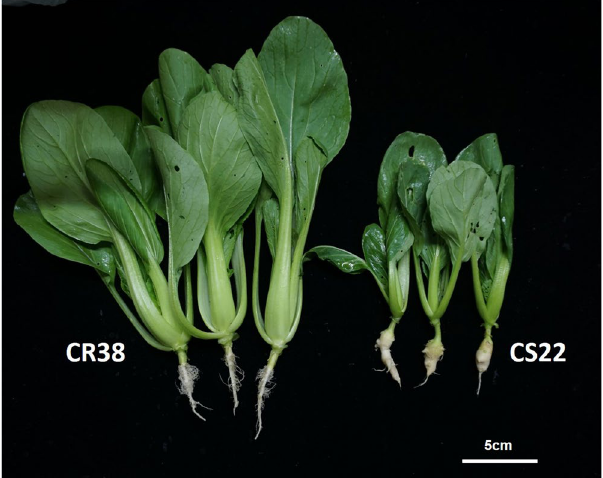
Figure 1. phenotype of the parents: CR38 (Clubroot resistance) and CS22 (Clubroot susceptible). Plants were inoculated with 7th physiology race of P. brassicae